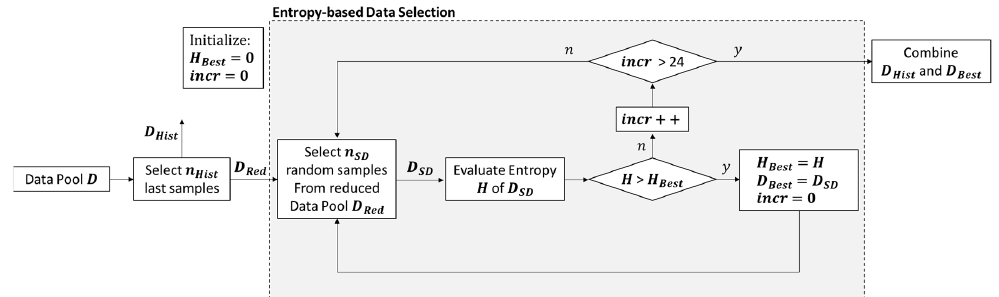
Figure 4. Representation of the algorithm for selecting training data enabling fast and accurate training of Gaussian process regressions for storage temperatures approximation.